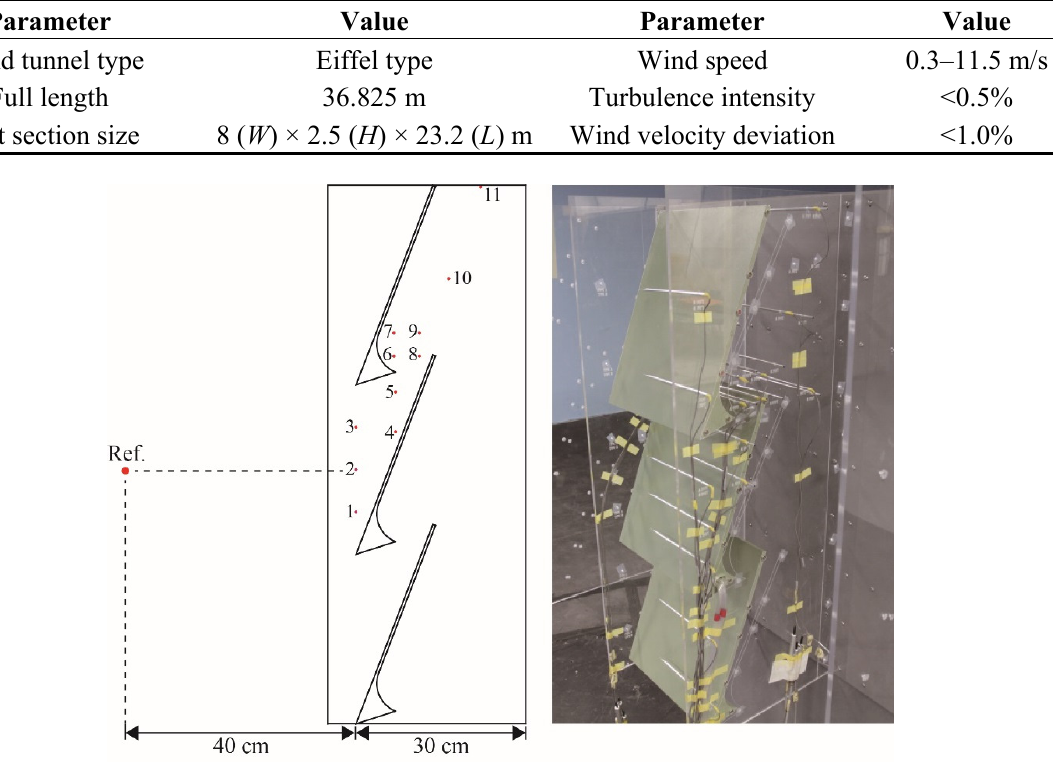
Figure 14. Measurement points on the scaled guide vane